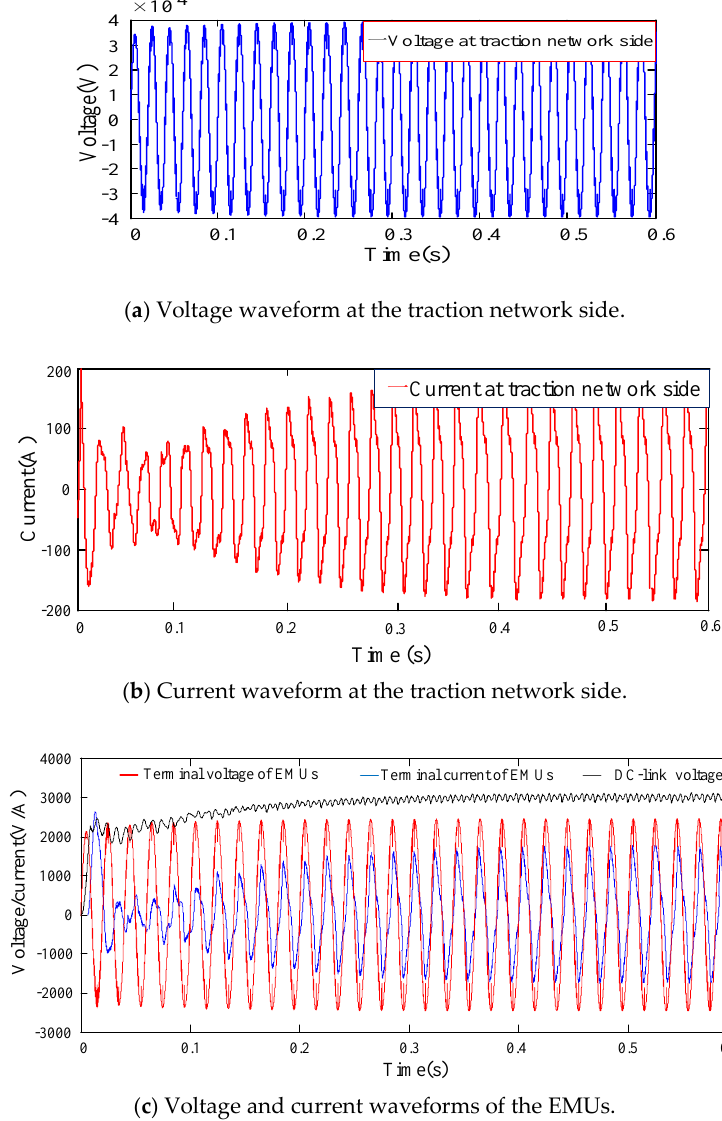
Figure 18. Voltage and current waveforms with six EMUs accessed based on the H∞ controller .